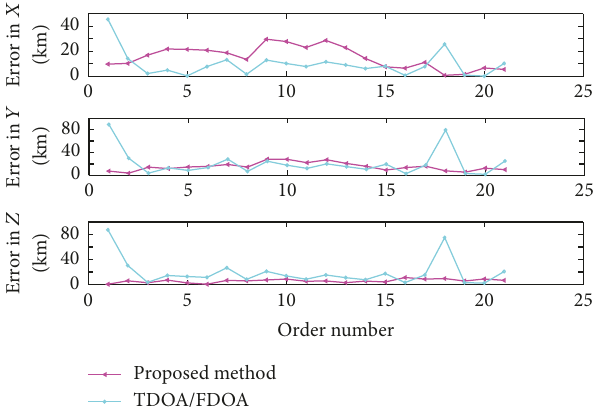
Figure 4: Positioning error in 𝑋 , 𝑌 , 𝑍 direction for records availability scenario.